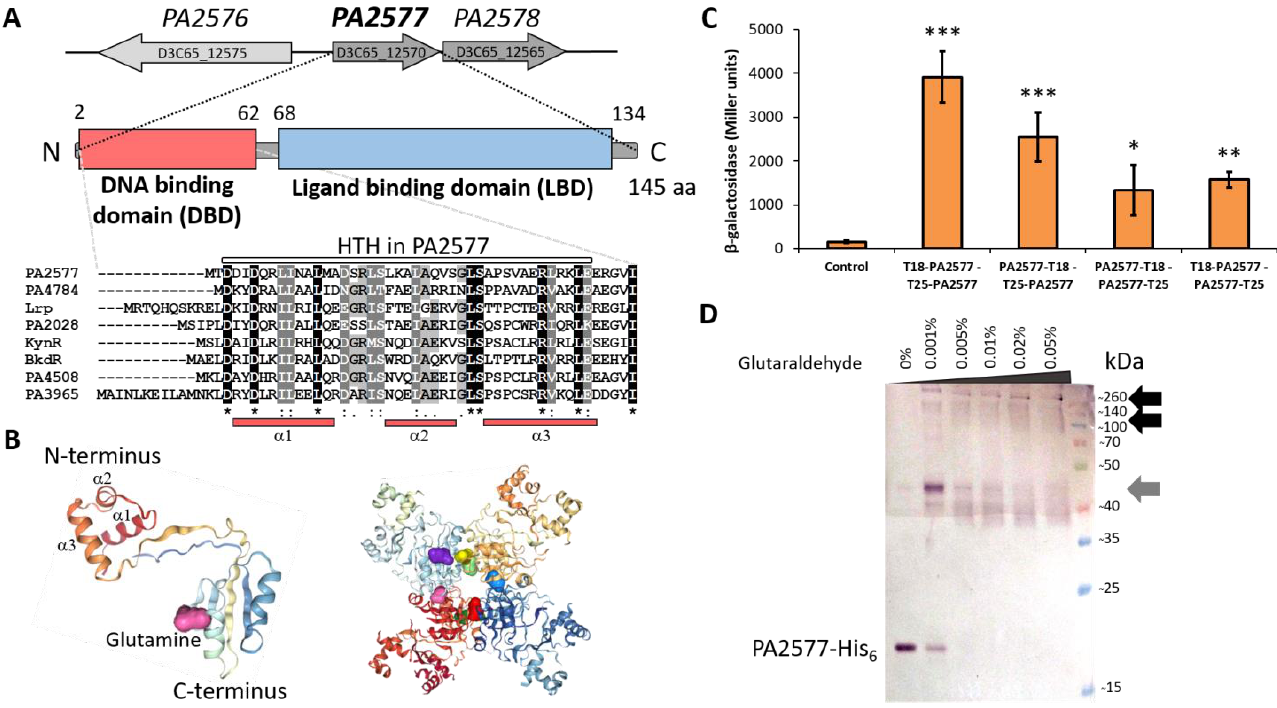
Figure 1. Properties of PA2577 protein from P. aeruginosa . ( A ) Genomic context of the PA2577 gene in the P. aeruginosa genome and domain structure of PA2577 protein. The gene names from PAO1 and PAO1161 strains are presented (PAO1 above the arrows presenting loci and PAO1161 inside arrows). Alignment represents a comparison of the PA2577 HTH domain with corresponding regions of 7 Lrp/AsnC proteins from PAO1. Identical residues in all proteins are marked with black. Dots and colons indicate similar residues. Amino acids predicted to be involved in the creation of α -helices are underlined (red bars). ( B ) Predicted structure of PA2577 monomer with marked α -helices creating HTH and an octamer with L-glutamine bound as the ligand. ( C ) BACTH analysis of PA2577 self-interactions. Data represent the mean β -galactosidase activity ± SD in cells from three or more cultures of E. coli BTH101 cyaA double transformants. Statistical significance was evaluated by t -test (* p -value < 0.05, ** p -value < 0.01, *** p -value < 0.001). ( D ) Oligomerization state of purified PA2577-His 6 assayed by cross-linking with glutaraldehyde. The same amount of purified His 6 -tagged protein was incubated at room temperature for 15 min with indicated glutaraldehyde concentrations. Samples were separated by SDS-PAGE using 12% gel and analyzed by Western blot with mouse anti-His 6 antibodies. Dimeric forms and oligomeric complexes are marked by grey and black solid arrows, respectively.